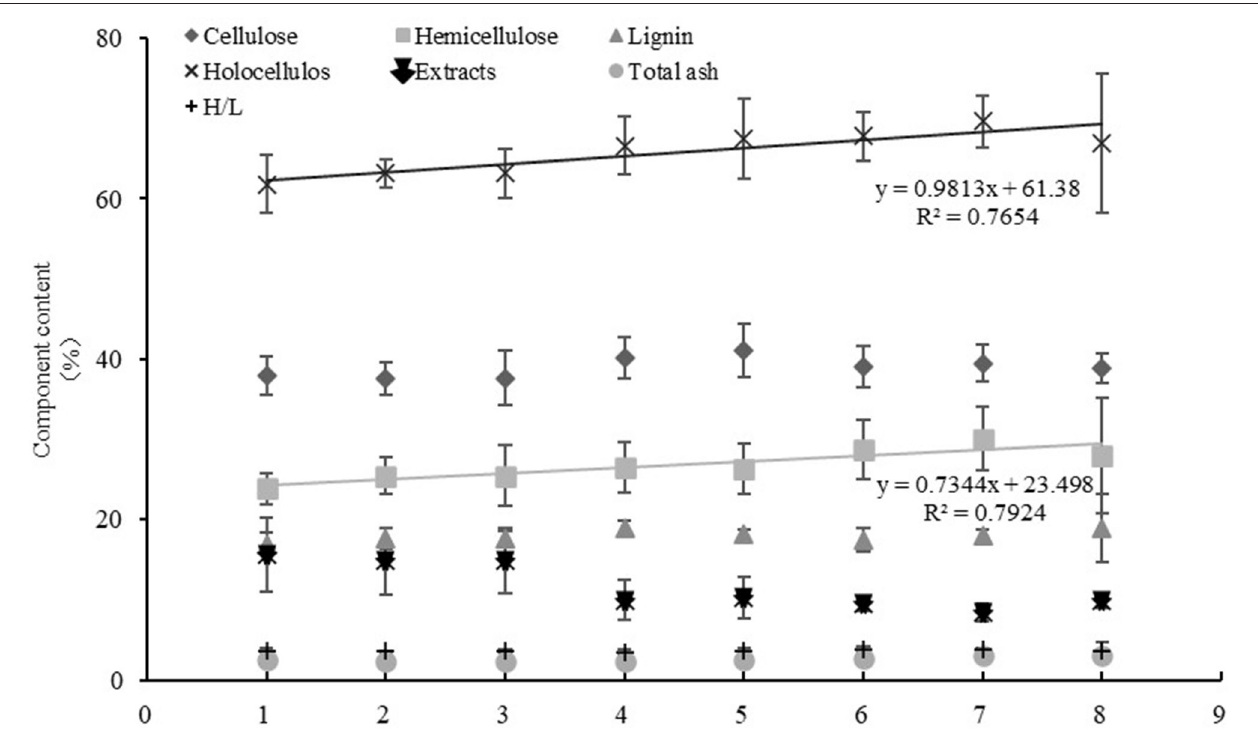
FIGURE 3 | Linear analysis of latitude and lignocellulosic components. 1: 30–32 N ◦ , 2: 32–34 N ◦ , 3: 34–36 N ◦ , 4: 36–38 N ◦ , 5: 38–40 N ◦ , 6: 40–42 N ◦ , 7: 42–44 N ◦ , 8: 44–46 N ◦